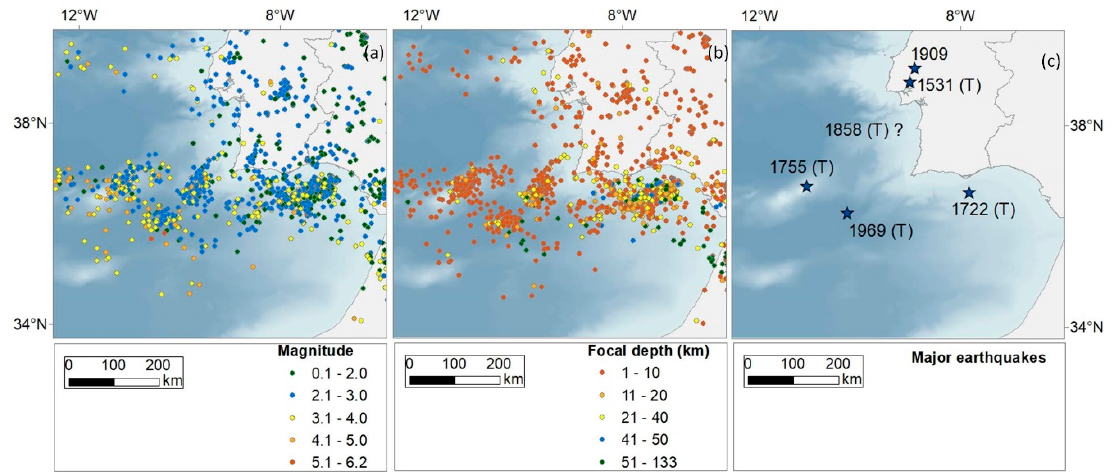
Figure 4. Seismicity of the East Section: (a) magnitude, (b) focal depth, (c) major earthquake. (T) indicates that the earthquake generated a tsunami. Data from United States Geological Survey (USGS), from 14 December 2000 to 14 December 2007 (adapted from [4,17]).